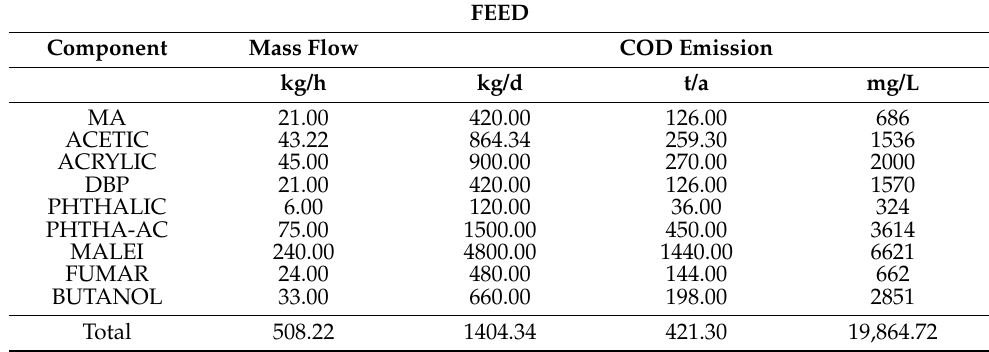
Table 8. Calculation of FEED stream COD.